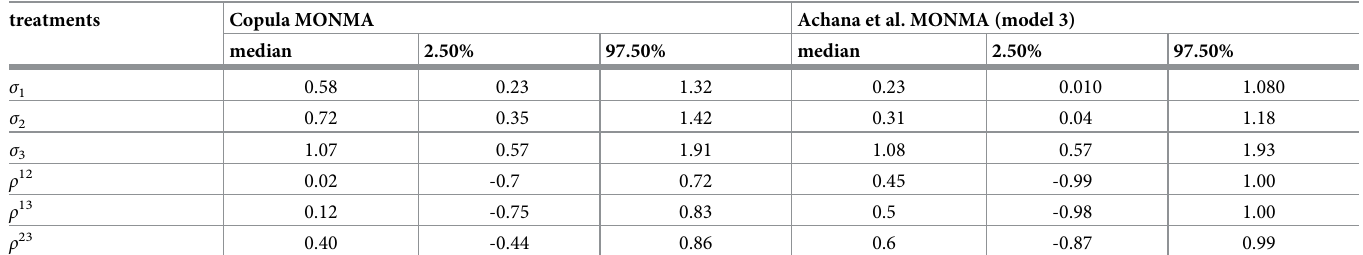
Table 4. Between-study standard deviations and correlations. treatments Copula